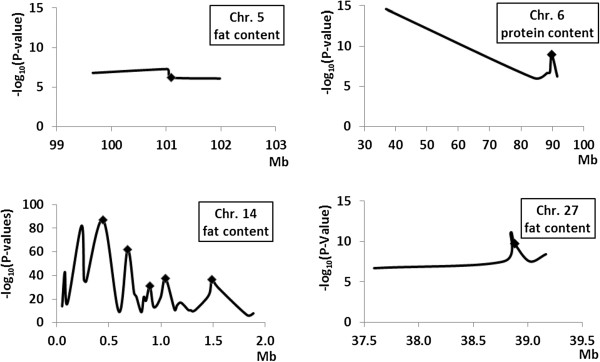
Averaged P-values across chromosomes including markers of 10-day intervals with and without accountancy of DGAT1. ♦ markers used to estimate genetic correlations within genotype classes.